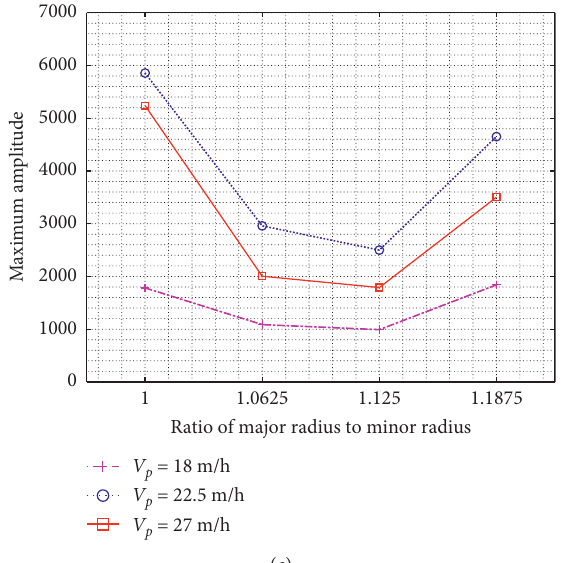
Figure 7: Curves of the maximum amplitude of the torque changing with R Vr � 45 r/min. (c) Rotation speed V r � 60r/min.